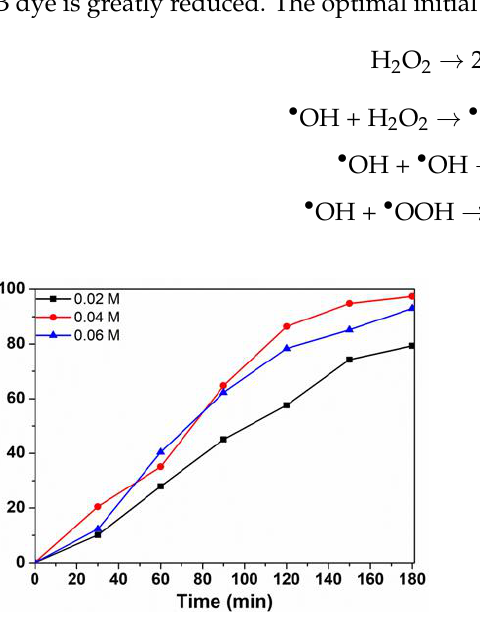
Figure 10. The influence of H 2 O 2 concentration on the efficient degradation of Rhodamine B using ZnNd 0 . 03 Fe 1 . 97 O 4 as Photo-Fenton.